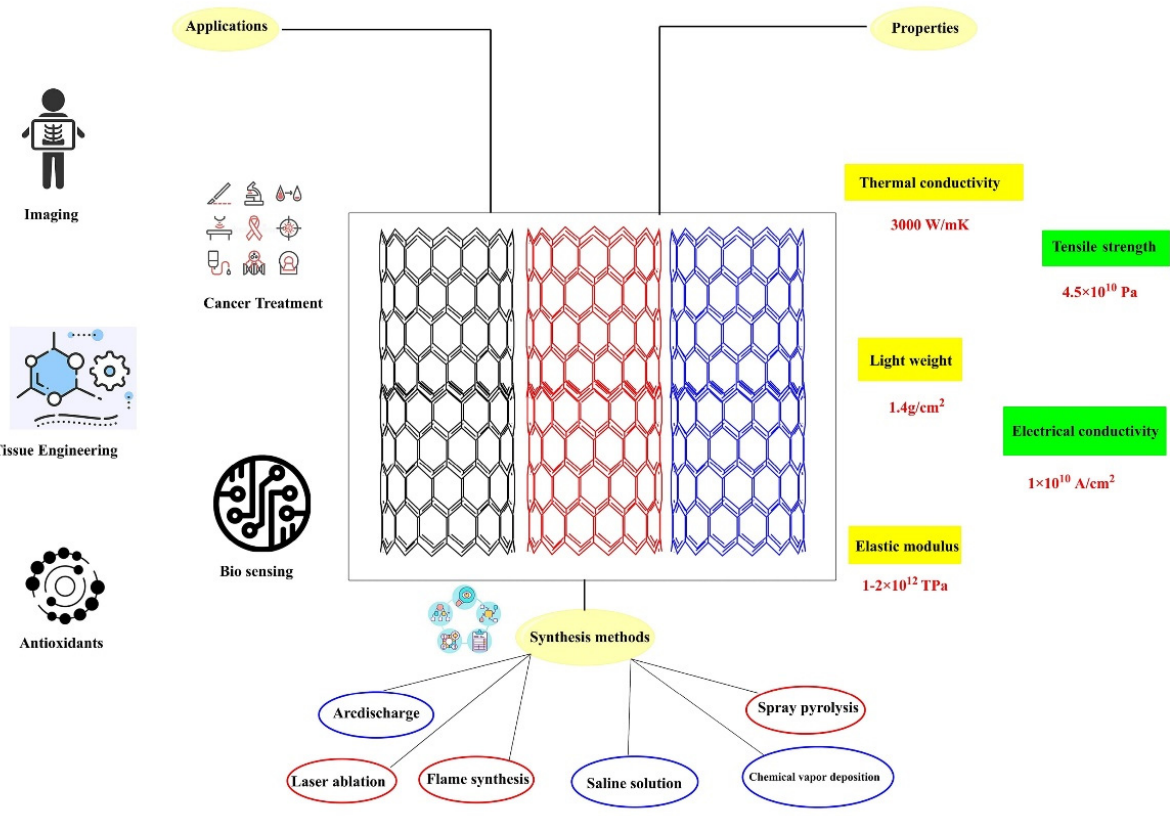
Figure 1. An overview of properties of CNTs and with synthetic and transdermal applications.